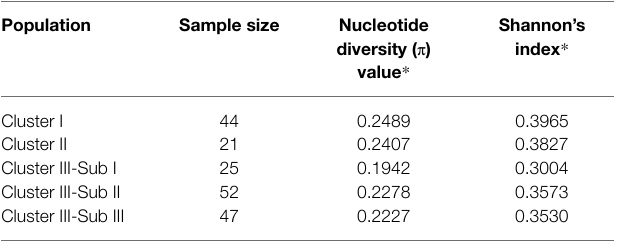
TABLE 6 | Diversity statistics of the populations across Solanum germplasm based on SSRs.